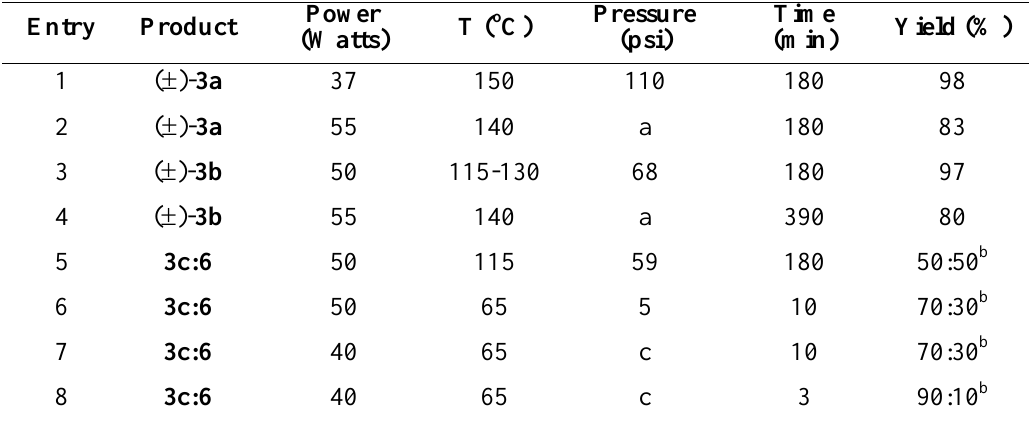
Table 1. 1,4-Addition of benzylamine to α , β -unsaturated